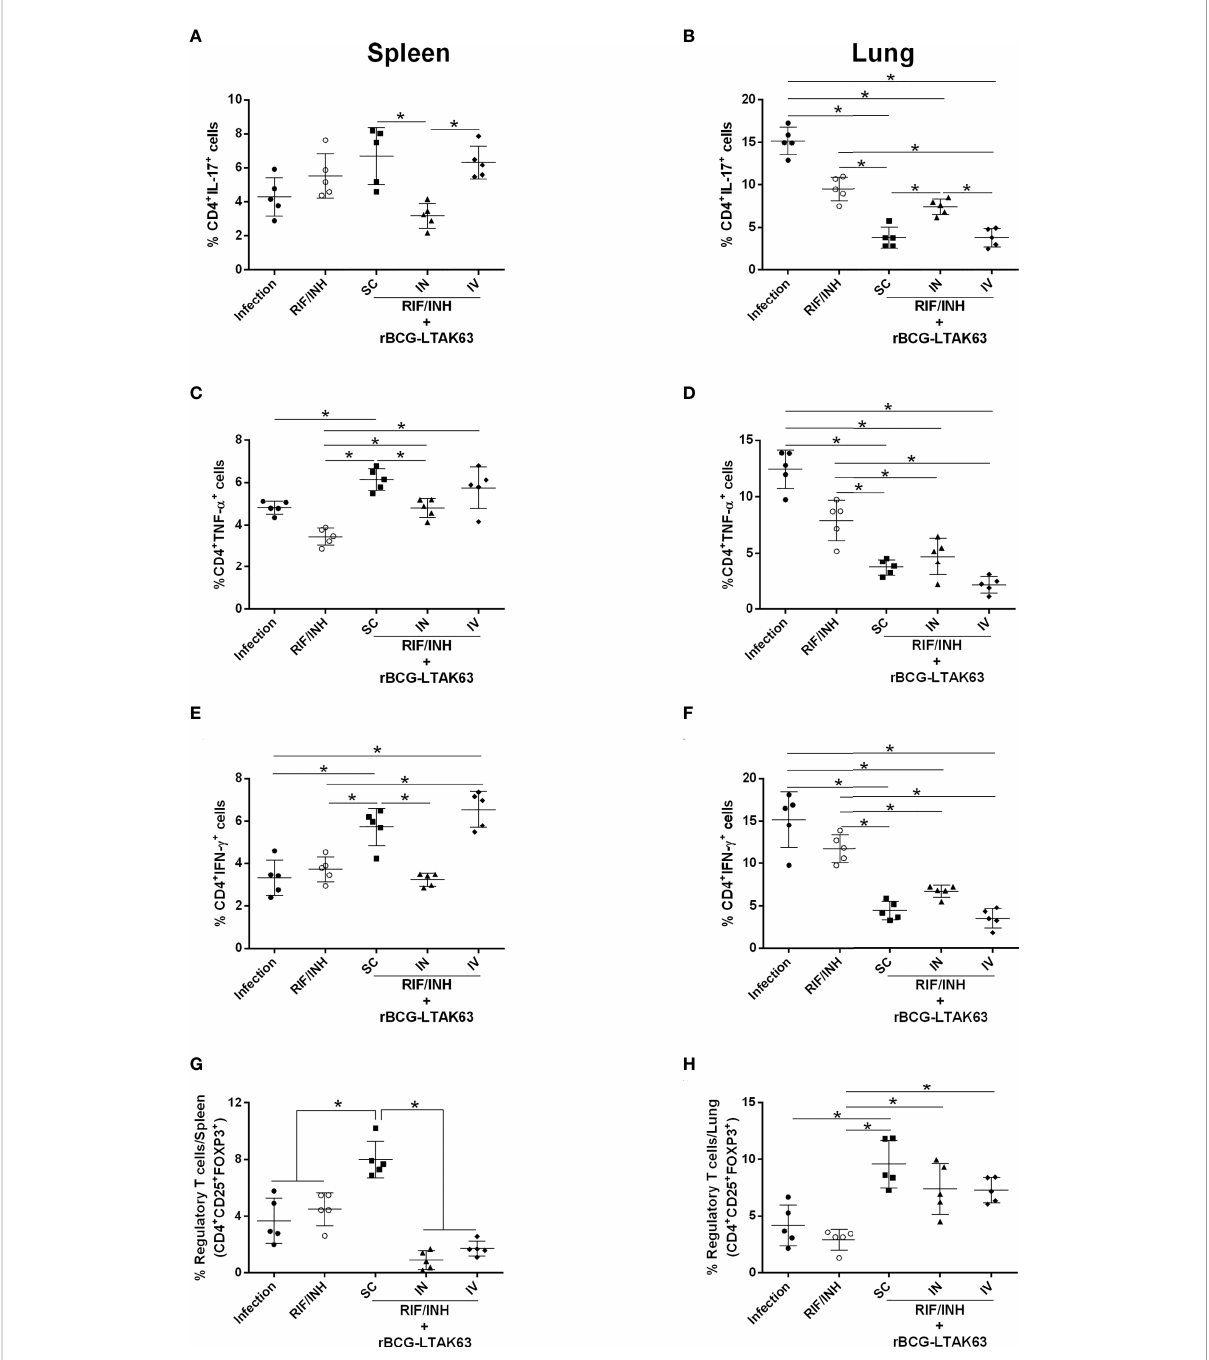
FIGURE 5 Reduced chemotherapy in combination with rBCG-LTAK63 modulates the immune response in the spleen and lungs of Mtb -infected mice. BALB/c mice were infected with Mtb (500 CFU/IN) and treated 4 weeks later with rifampicin and isoniazid (RIF/INH) for 2 weeks. After two weeks interval, rBCG-LTAK63 treatment was administered via SC, IN or IV routes. Eight weeks after treatment, spleens and lungs were recovered, and the number of CD4+ T cells producing IL-17 (A, B) , TNF- a (C, D) and IFN-y (E, F) in these organs was determined by staining with mouse monoclonal antibodies antiCD3-APC.CY7, anti-CD4-PercP and anti-IL17-BV421, anti-TNF-PE, anti-IFN-APC. Regulatory T cells (G – H) were stained using mouse monoclonal antibodies anti-CD4-PercP, anti-CD25-PE and anti-FoxP3-APC, and analyzed using Flow Cytometer FACS Canto II and FlowJo 8.7 software. Statistical differences were determined by one-way ANOVA with a Bonferroni test. * p values ≤ 0.05 were considered statistically signi fi cant. Asterisks over the columns refer to the comparison with the infection group. Results are represented by the means ± SD